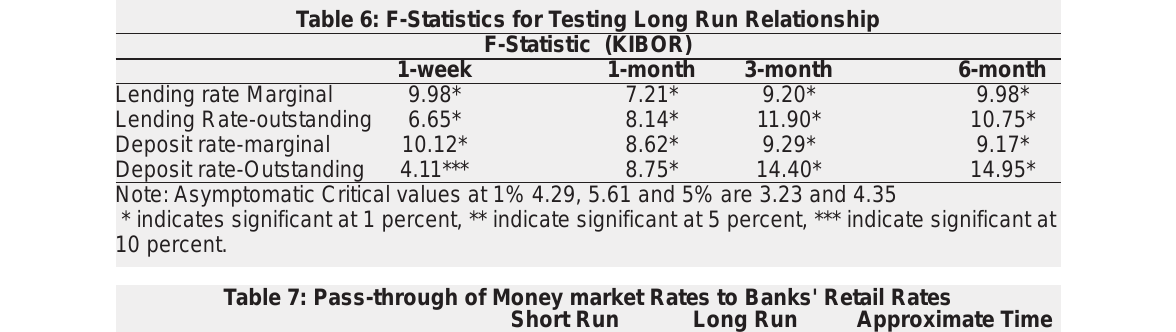
Table 7: Pass-through of Money market Rates to Banks' Retail Rates Short Run Long Run Approximate Time Pass-through of 1-week KIBOR Lending Rates-Marginal 0.30